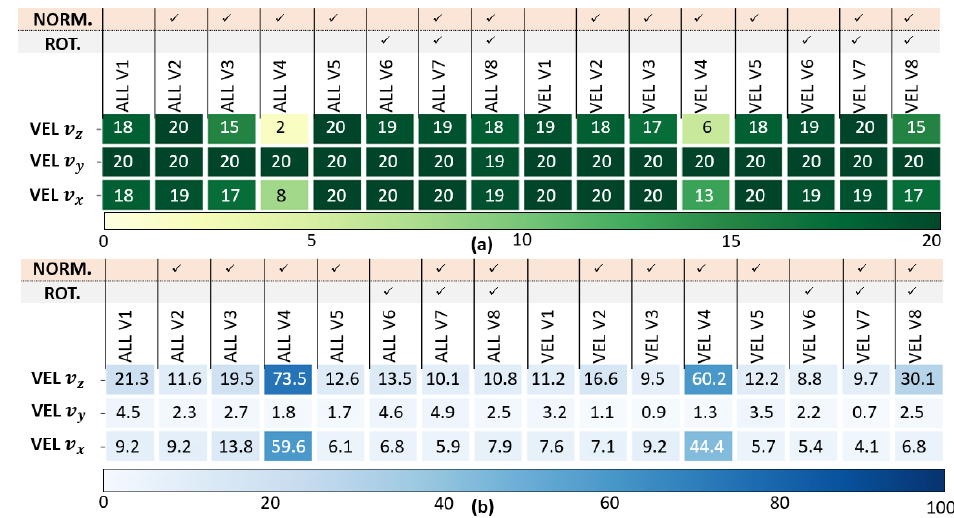
Figure 7. Velocity analysis: ( a ) Success Rate C 1 , ( b ) Error Rate C 2 (in %) of LSTM ALL , V LSTM VEL , V . 1 − V 8